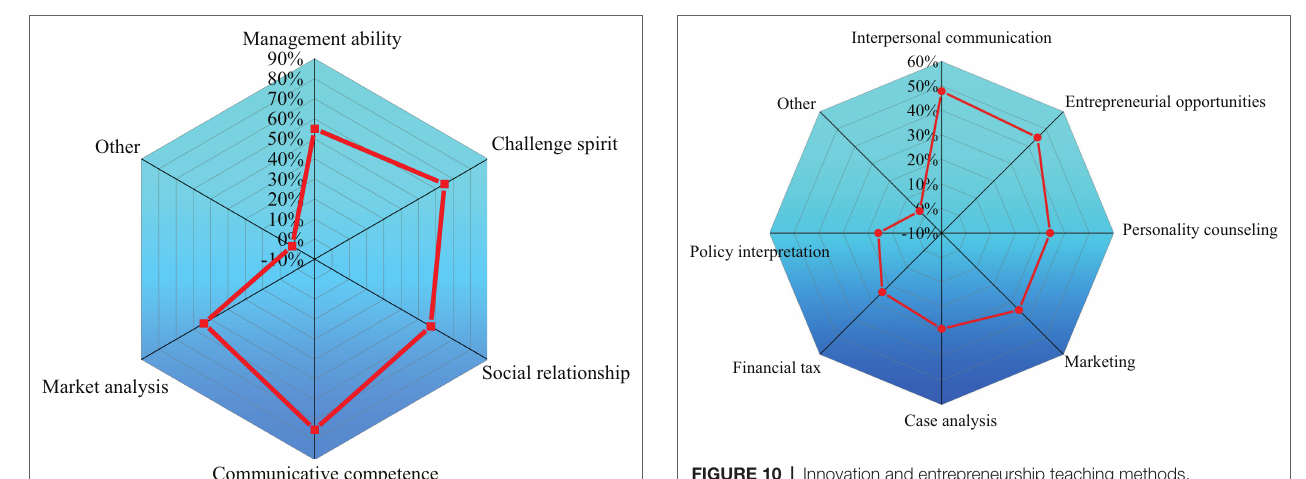
FIGURE 10 | Innovation and entrepreneurship teaching methods.